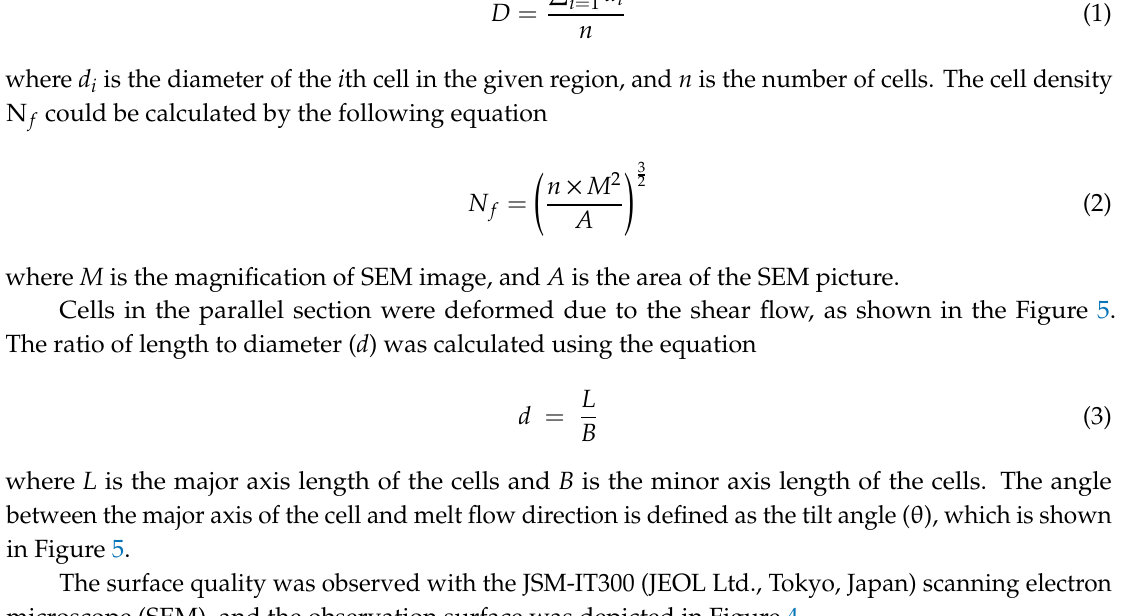
Figure 5. Schematic diagram of ratio of length to diameter ratio and tilt angle.